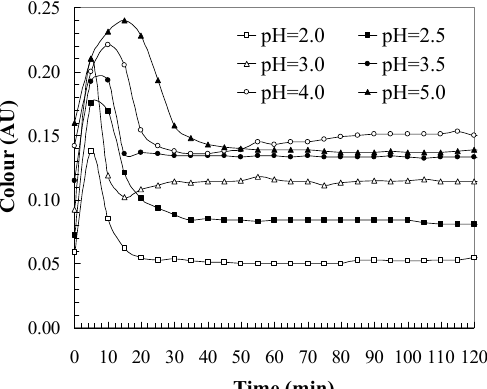
Figure 2. pH effect on colour changes in a photo-Fenton system during the carbamazepine oxidation. Experimental conditions: [CBZ] 0 = 50.0 mg/L; [H 2 O 2 ] 0 = 15.0 mM; [Fe] 0 = 10.0 mg/L; [UV] = 150 W; T = 40 °C.